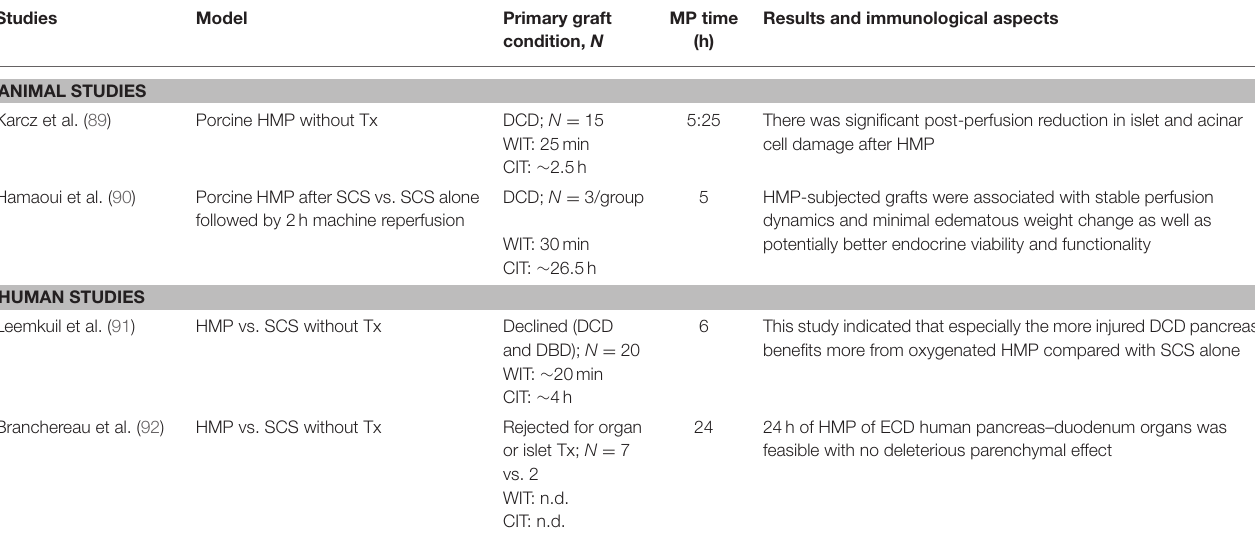
TABLE 5 | Experimental and clinical studies of machine perfusion of extended criteria donor pancreas grafts. Studies Model Results and immunological